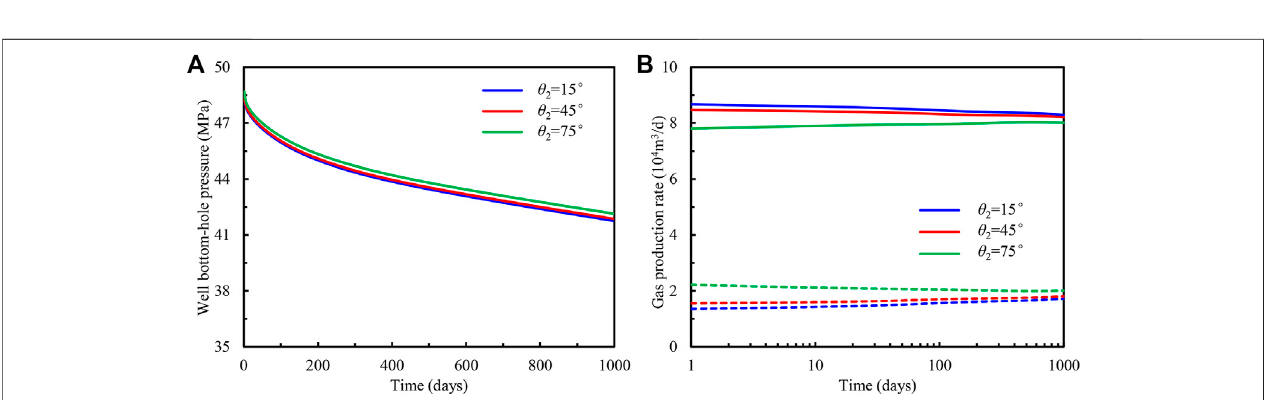
FIGURE 12 | In fl uence of inclination angle in the second layer on (A) bottom-hole fl owing pressure and (B) gas production of individual formation.